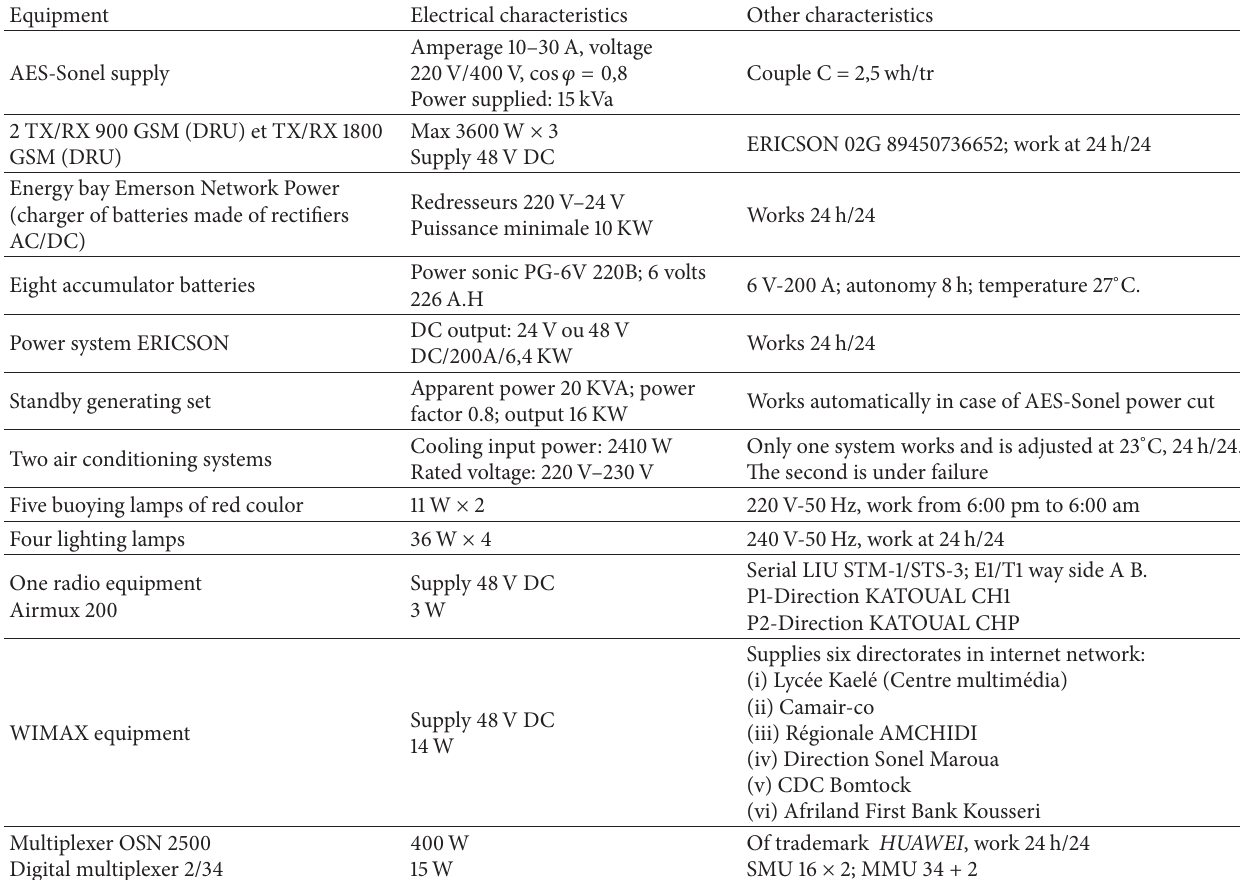
Table 4: Equipment of MTN Missinguileo